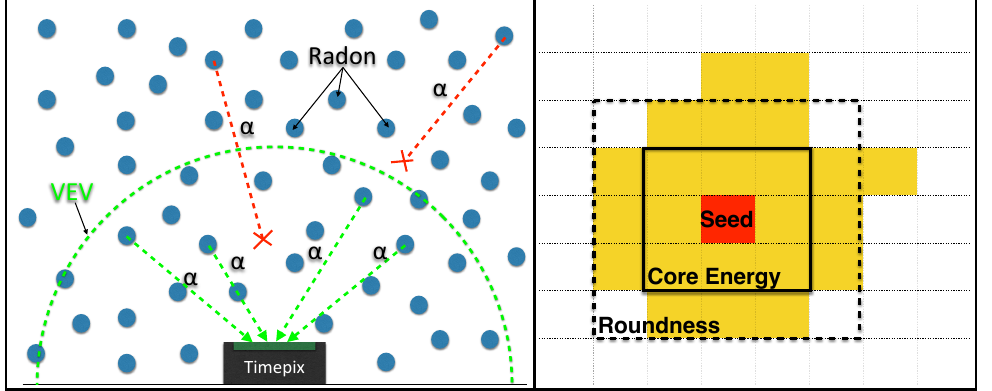
Figure 4. Timepix ‘bare’ configuration sketch for radon measurements (left canvas). The Virtual Enclosure Volume (VEV) surrounds the TimePix and includes all the atoms that can emit α particles capable to deposit some energy in the detector active area. For a given α particle energy, the maximum path-length traveled by the particle releasing an infinitesimal energy (cid:101) > 0 in the silicon active area provides the volume dimension. In the right canvas a sketch of an α cluster, with the seed in red (color on-line) and the squares used to define variable C (3 × 3) and variable R (5 ×